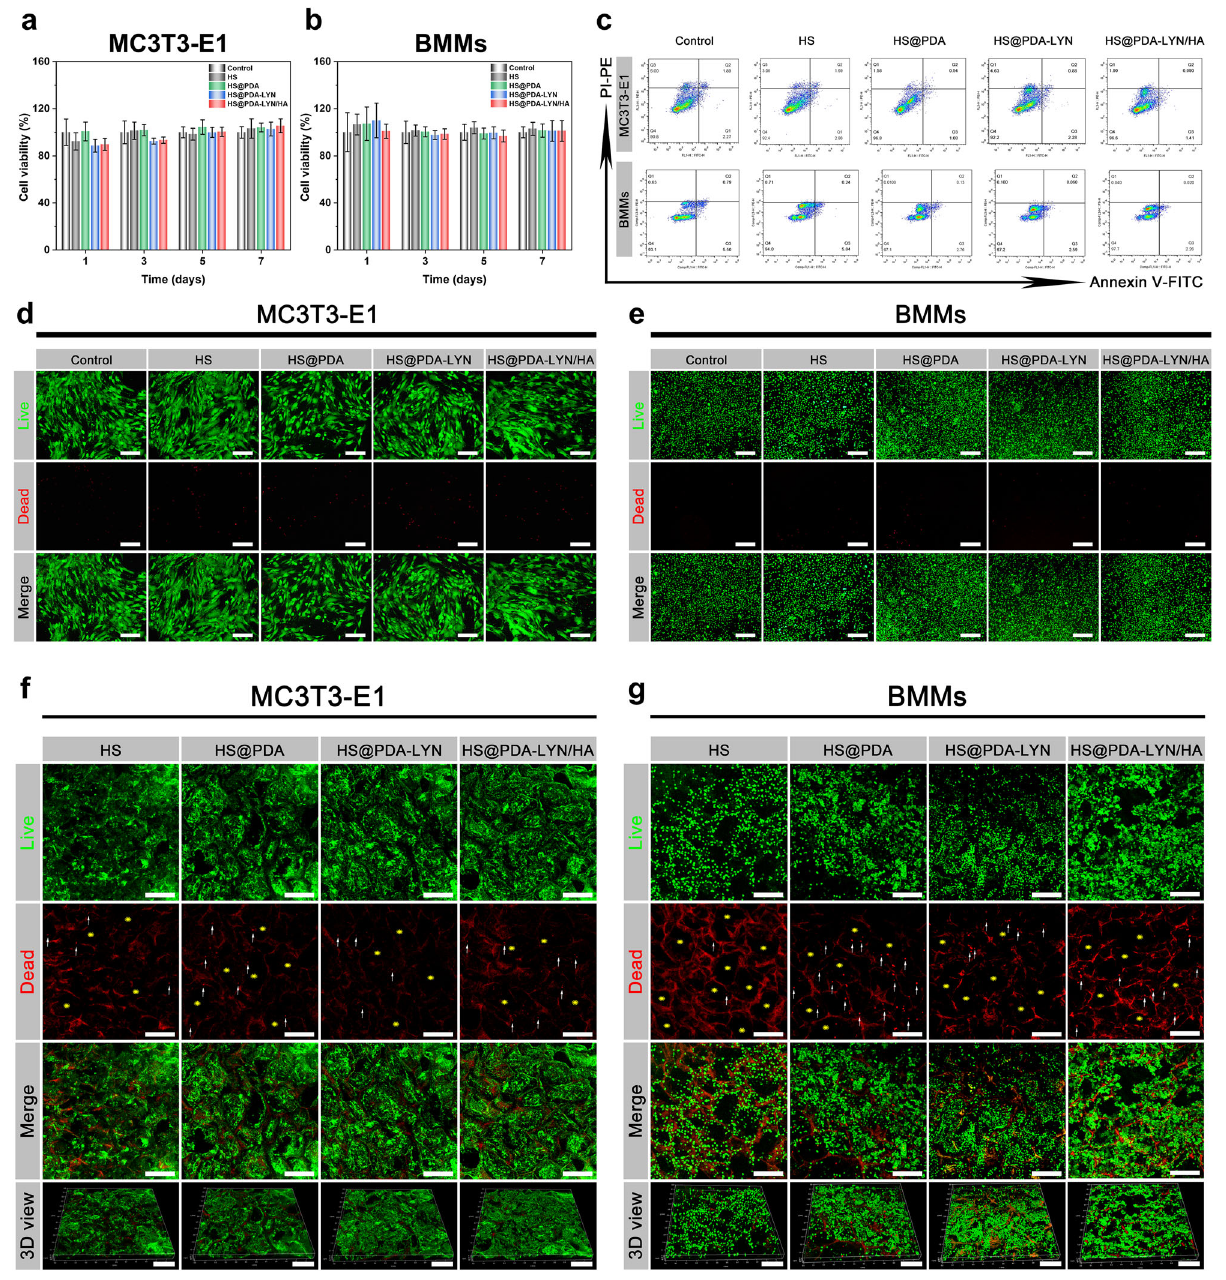
Fig. 3 Cytocompatibility of the surface-modi fi ed HS 3D scaffold with LYN and HA in vitro. Cell viability of a MC3T3-E1 cells and b BMMs detected using the CCK-8 assay after culturing with scaffold extracts for 1, 3, 5, and 7 days. c Representative dot plots of annexin-V and PI double-stained MC3T3-E1 cells and BMMs following various treatments. Annexin V-FITC was used to identify early apoptotic cells by showing green fl uorescence, and PI was used to identify late apoptotic cells by showing red fl uorescence. Q1 represents the percentage of necrotic cells, Q2 represents the percentage of late apoptotic cells, Q3 represents the percentage of early apoptotic cells, and Q4 represents the percentage of live cells. Representative fl uorescence images of live/dead staining of d MC3T3-E1 cells and e BMMs cocultured with different scaffold extracts for 3 days. Representative confocal fl uorescence images of live/dead staining of f MC3T3-E1 cells and g BMMs cultured on scaffold surfaces for 3 days. The live cells were stained green, and dead cells were stained red. The yellow asterisks indicate the 3D porous structure of the fabricated scaffolds. The white arrows indicate dead cells. Scale bar in d , e : 200 μ m, in f , g : 250 μ m. Data are expressed as the mean ± SD ( n =